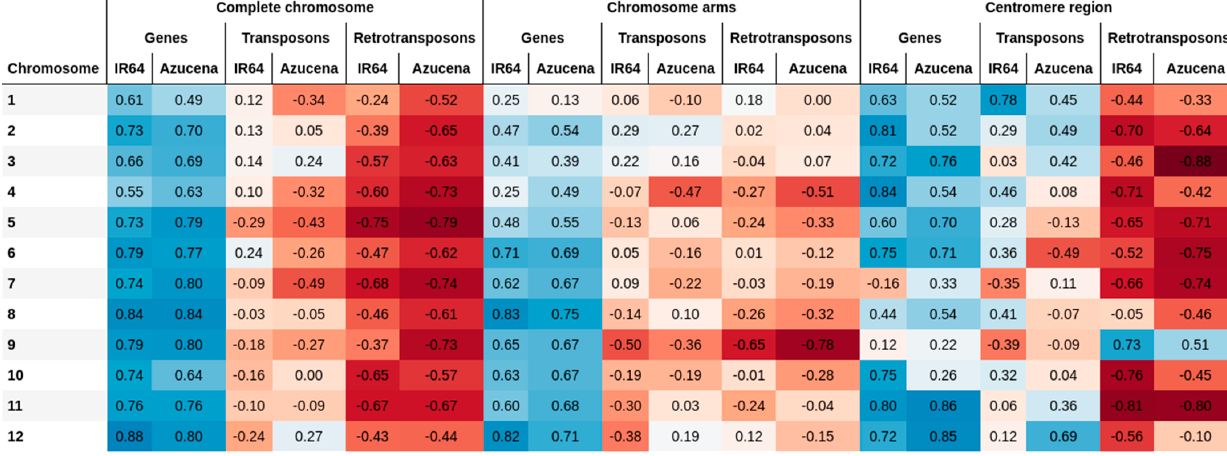
Figure 5. Correlations between recombination rates and the number of genes, transposons, and retrotransposons rates for rice varieties IR64 and Azucena. Blue and red colors correspond to positive and negative correlations, respectively. The higher the correlation value, the higher the color intensity.